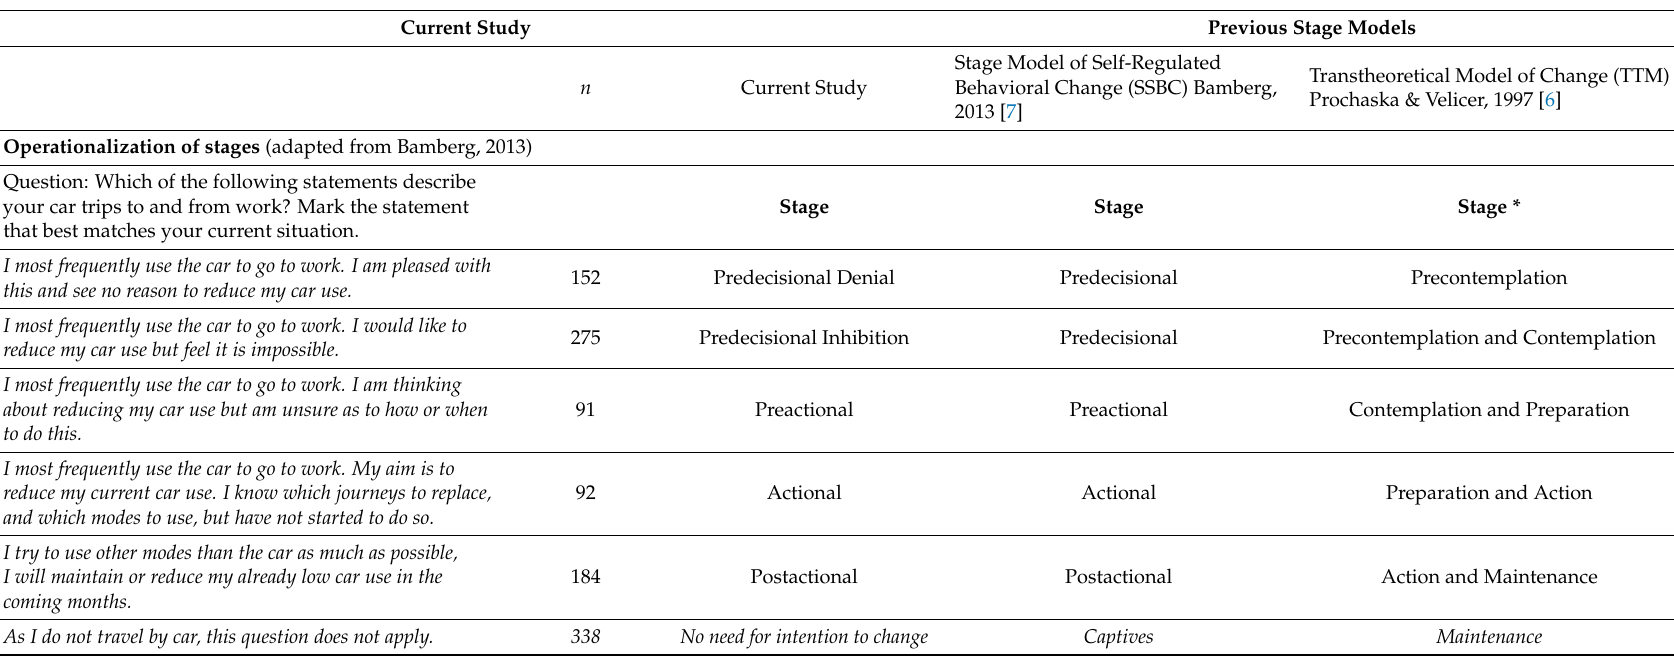
Table 1. Operationalization of stages of intention to change in the current study, related to the stages in SSBC and